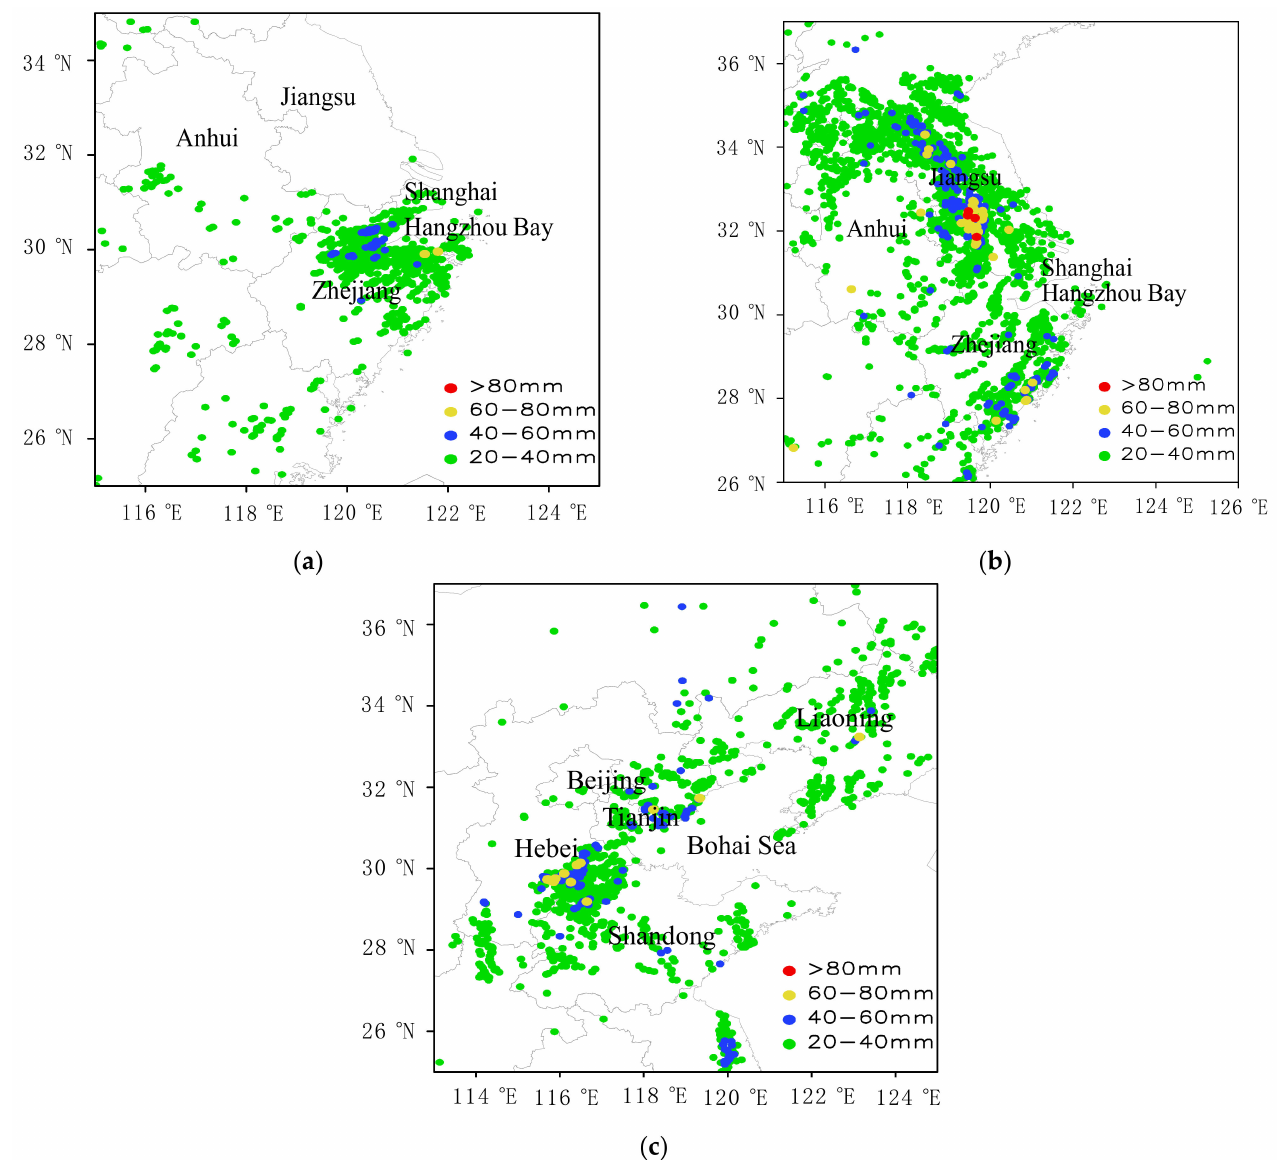
Figure 4. Maximum hourly rainfall distribution of In-Fa (unit: mm). ( a ) Stage 1: 0800 BT on 22